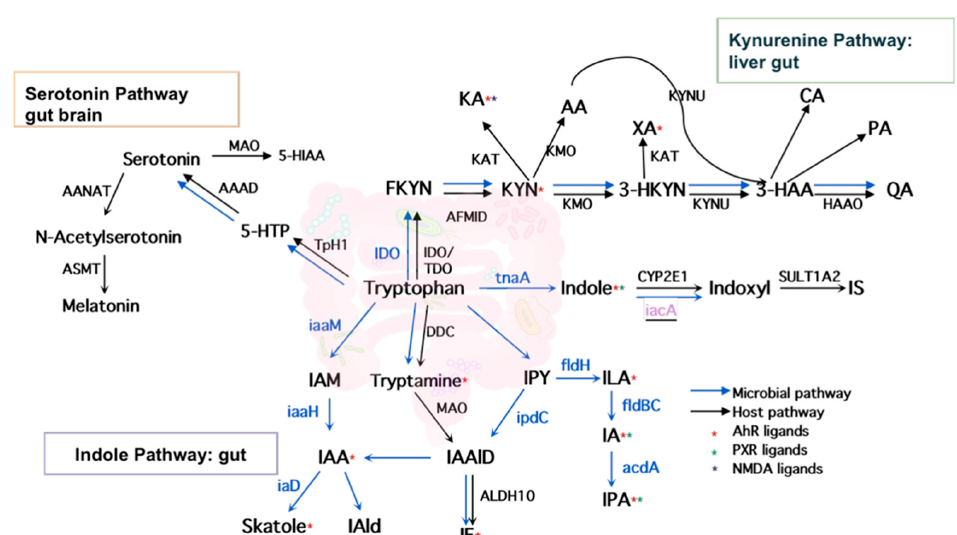
Figure 2. Host and microbial tryptophan metabolism pathways.